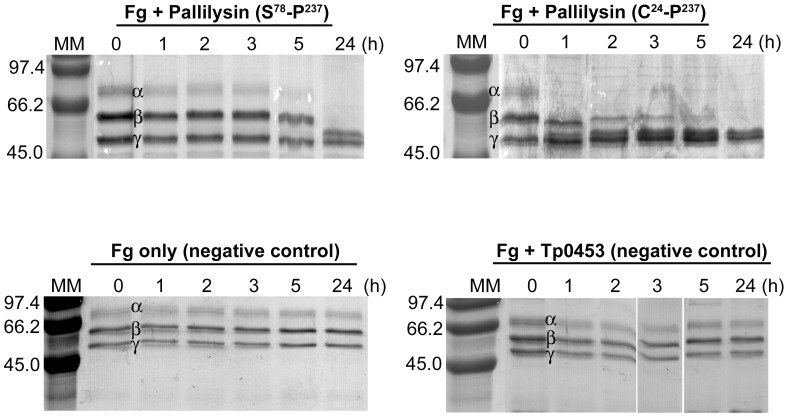
Pallilysin thrombin site truncation results in enhancement of fibrinogenolysis.Tagless pallilysin (S78-P237 and C24-P237) purified from E. coli (30 µg) was incubated with fibrinogen (60 µg) at 37°C for 24 h. Samples were analyzed by SDS-PAGE to detect degradation of the fibrinogen α-, β-, and γ-chains. Controls included fibrinogen (60 µg) incubated in buffer alone (Fg only) and fibrinogen (60 µg) incubated in the presence of the recombinant negative control Tp0453 (Fg + Tp0453) (30 µg). Each lane contains approximately 5 µg of protein (in the absence of fibrinogen degradation). Numbers to the left of the lanes indicate the size (kDa) of the corresponding molecular mass (MM) markers.